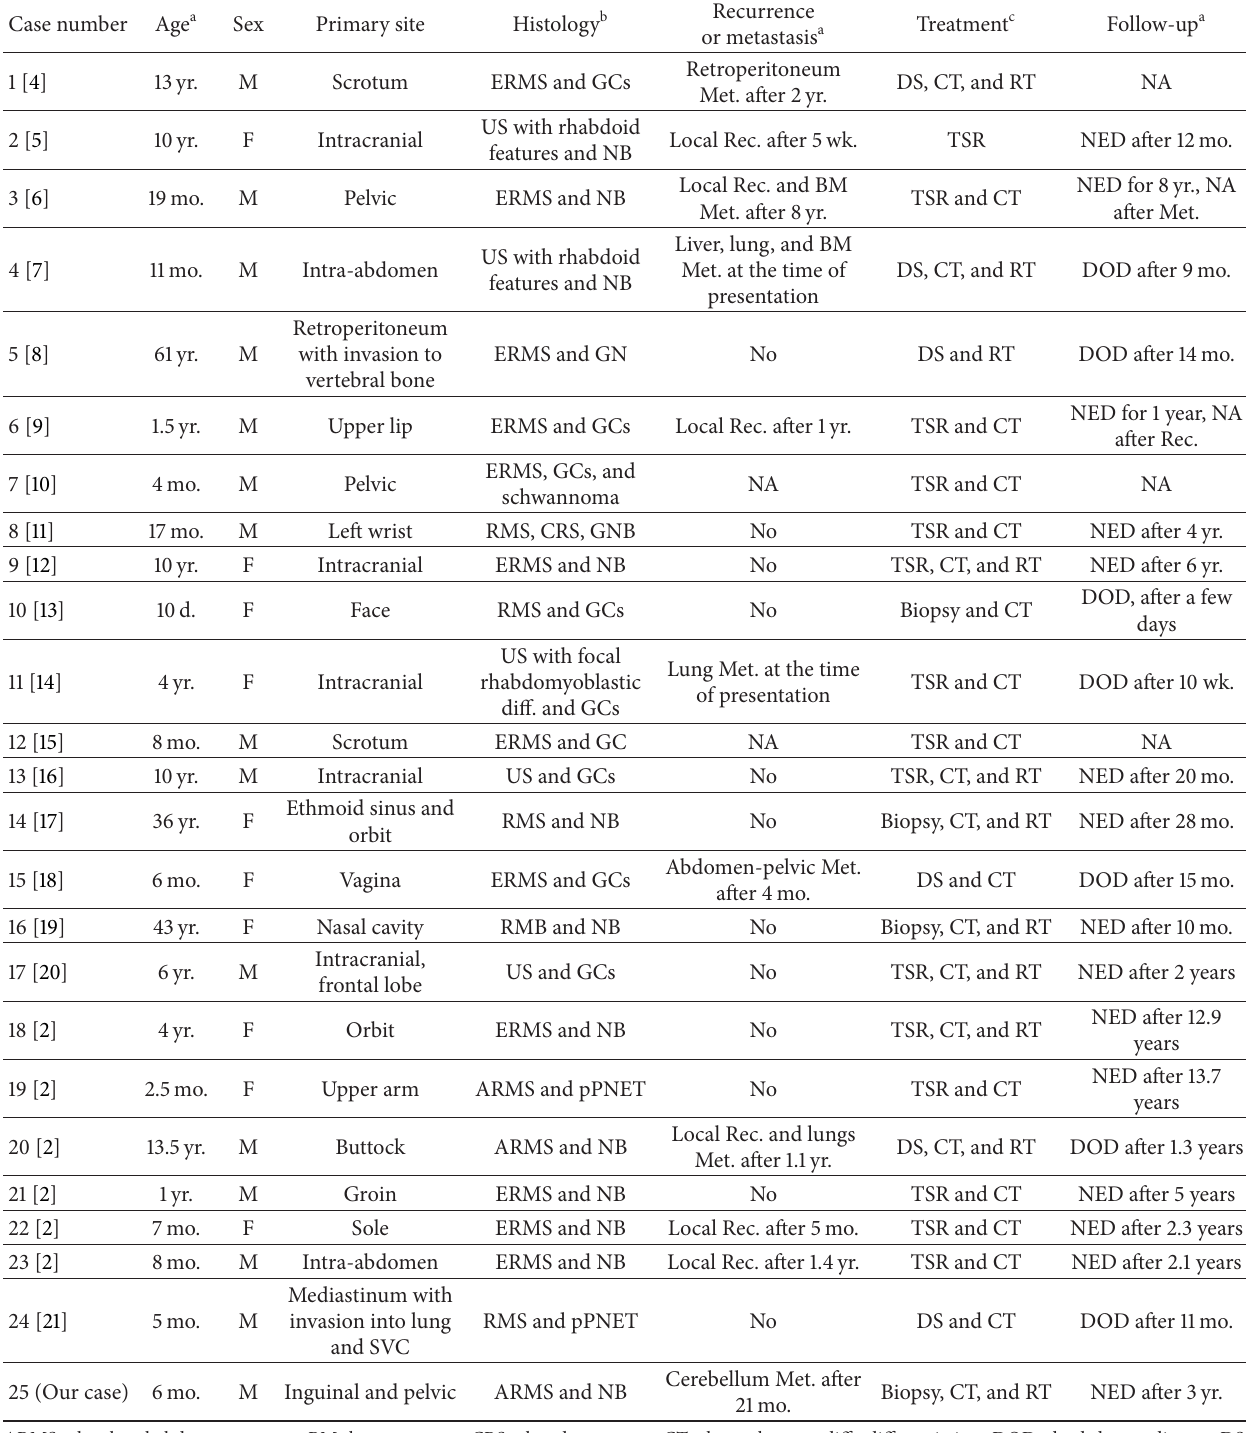
Table 1: Review of malignant ectomesenchymoma cases reported after